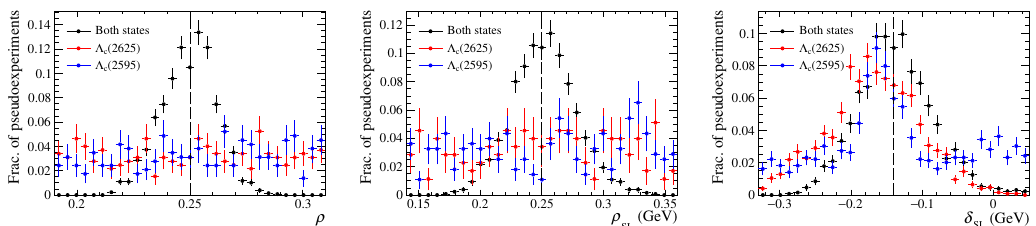
Figure 2 . Distribution of the IW parameters as (cid:12)tted from an ensemble of pseudo-experiments. The distributions are shown for the cases when one of the two (cid:3) (cid:3) + combination of both. The dashed lines indicate the numerical values of the parameters used to generate the